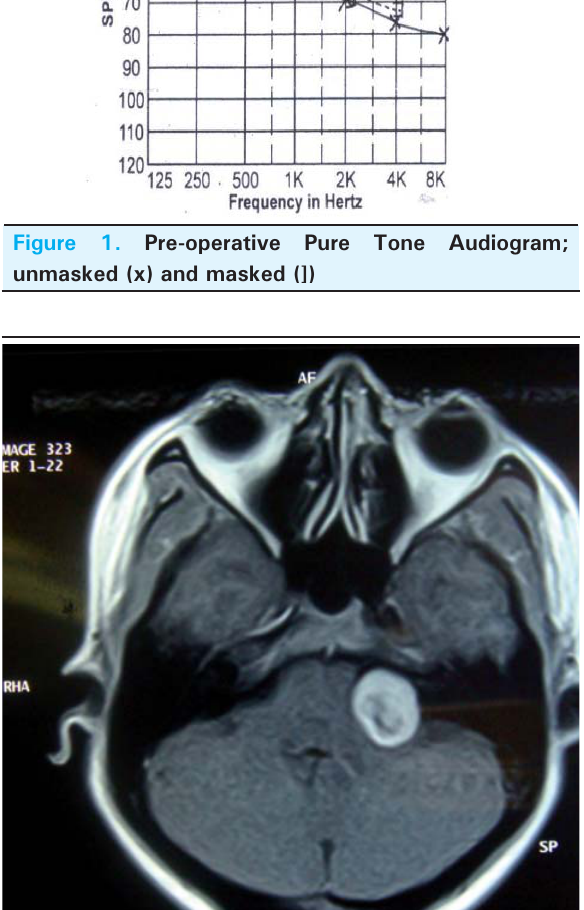
Figure 4. Contrast enhanced axial T1 weighted MRI scan at 12 months follow up shows no residual